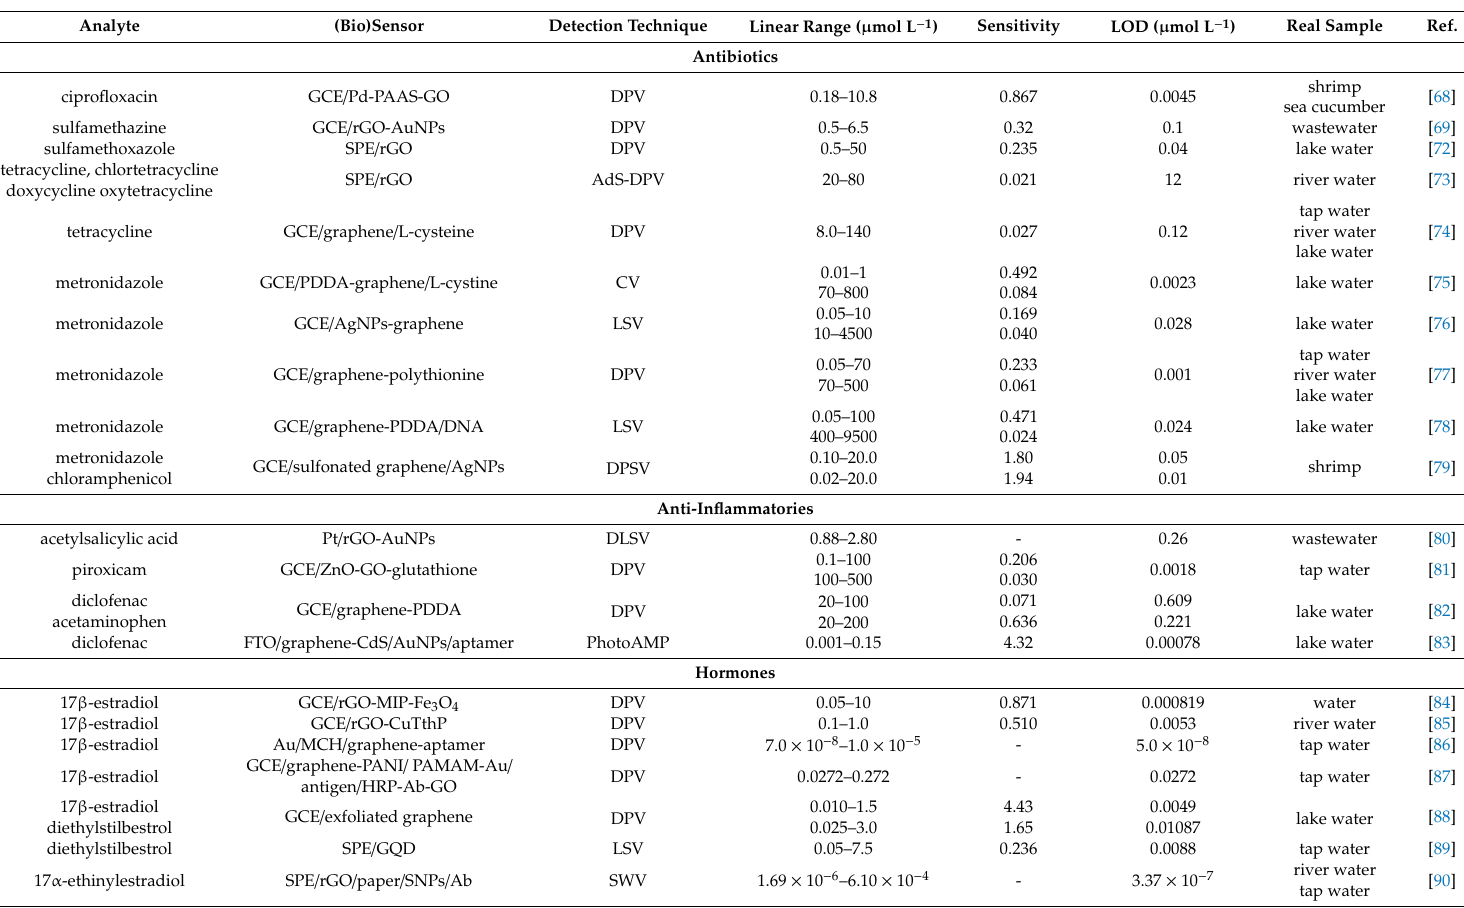
Table 1. Graphene-based electrochemical (bio)sensors for emerging pharmaceutical pollutants in aquatic species and environmental